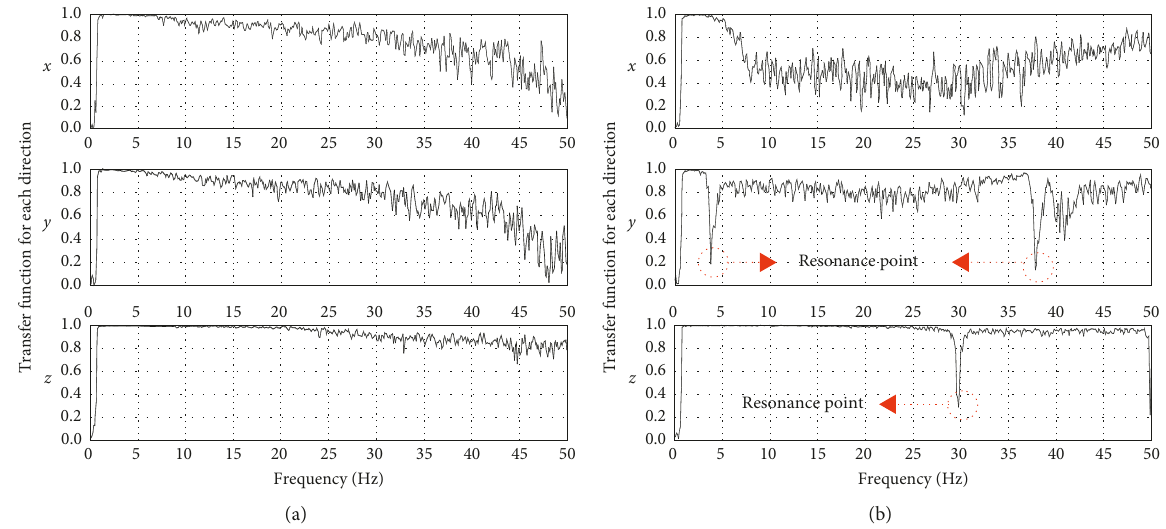
Figure 5: Transfer functions of the shake table device with (a) inertia and (b) elastic